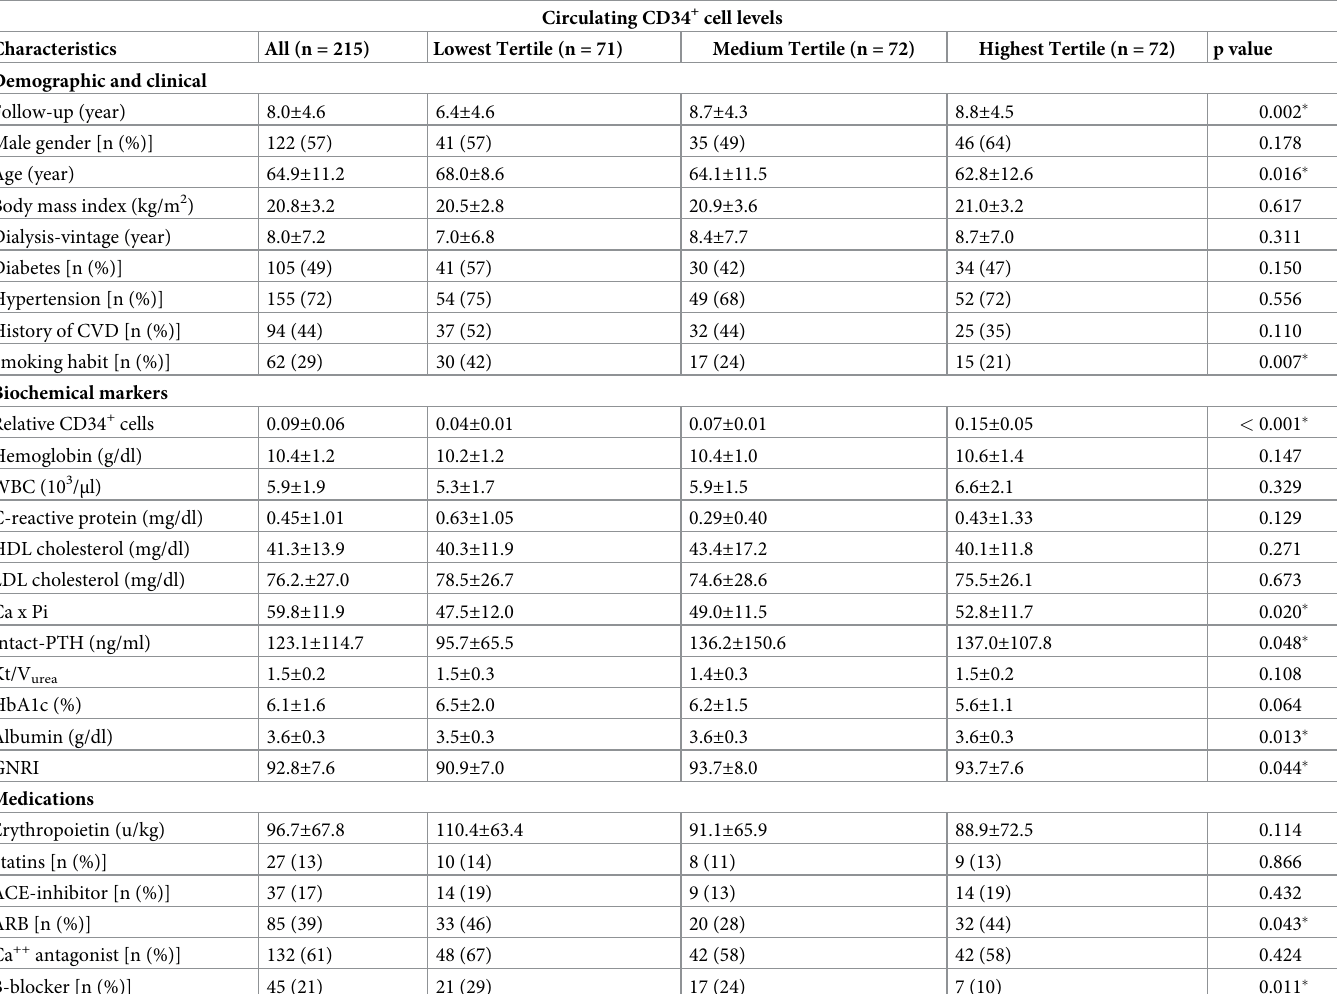
Table 1. Baseline characteristics of study participants according to CD34 +